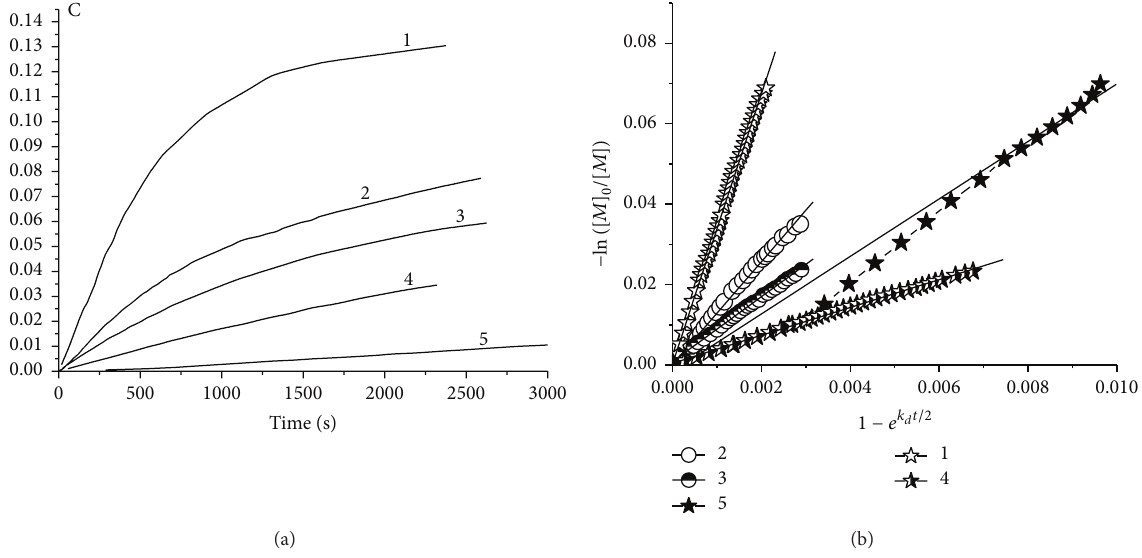
Figure 2: Conversion-time curves based on dilatometric results (a) and data of ln [𝑀] 0 /[𝑀] as a function of 1 − (1 − 𝑒 𝑘 𝑑 𝑡/2 ) according to (5) (b), where 2-poly(NMNVA) in 1,4-dioxane; 3-poly(NMNVA) in toluene; 5-poly(NAM) in 1,4-dioxane; 1-poly(NAM) in THF; 4-poly(NAM) in